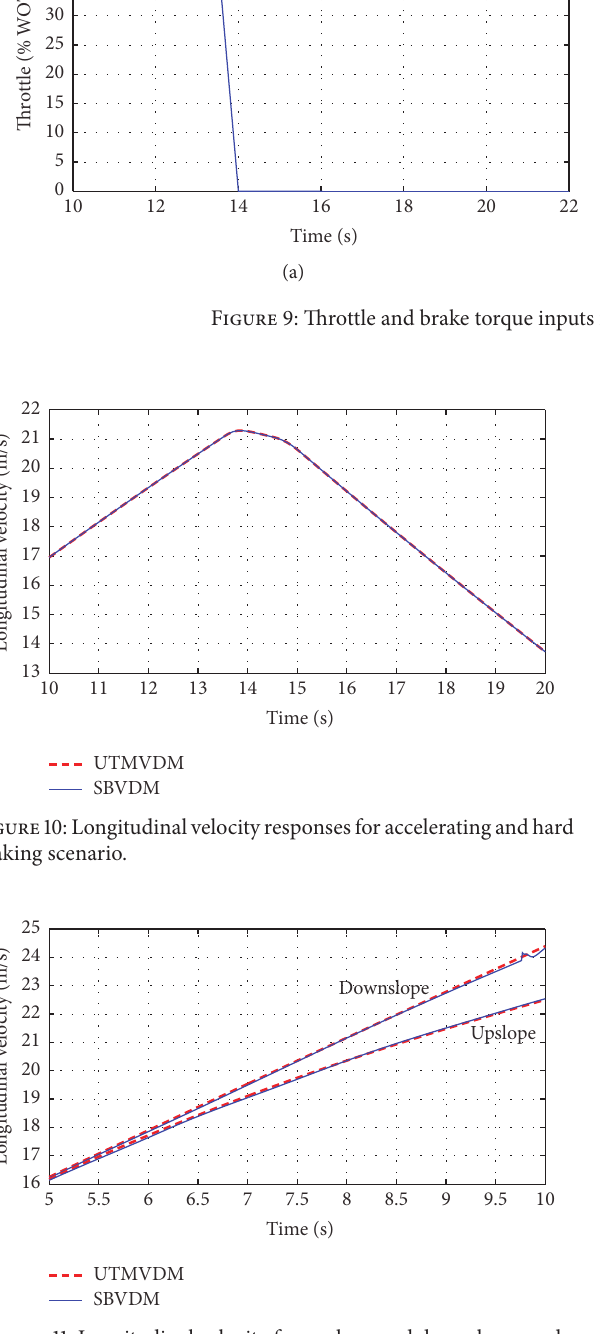
Figure 11: Longitudinal velocity for upslope and downslope road.